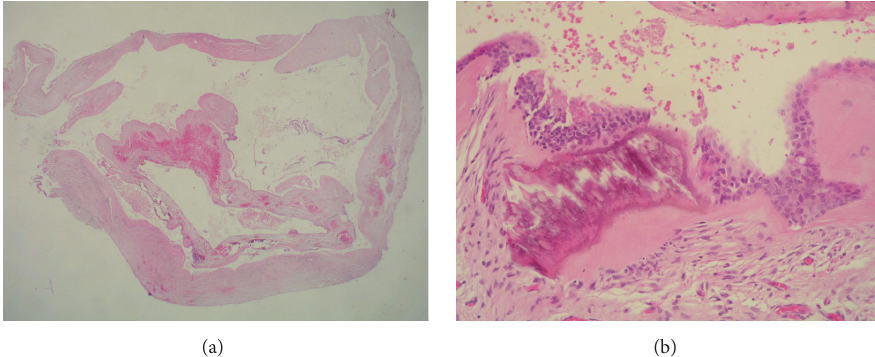
Figure 8: (a) Histology: overview of the cystic tissue with focally intact epithelium and loose fibrotic stroma (haematoxylin and eosin; original magnification × 20). (b) Histology: cystic wall with thin, fibrotic, and partly edematous tissue. Little inflammatory infiltrate with granulocytes; cyst lined by a combination of stratified nonkeratinizing squamous epithelium and pseudostratified ciliated columnar epithelium (haematoxylin and eosin; original magnification ×